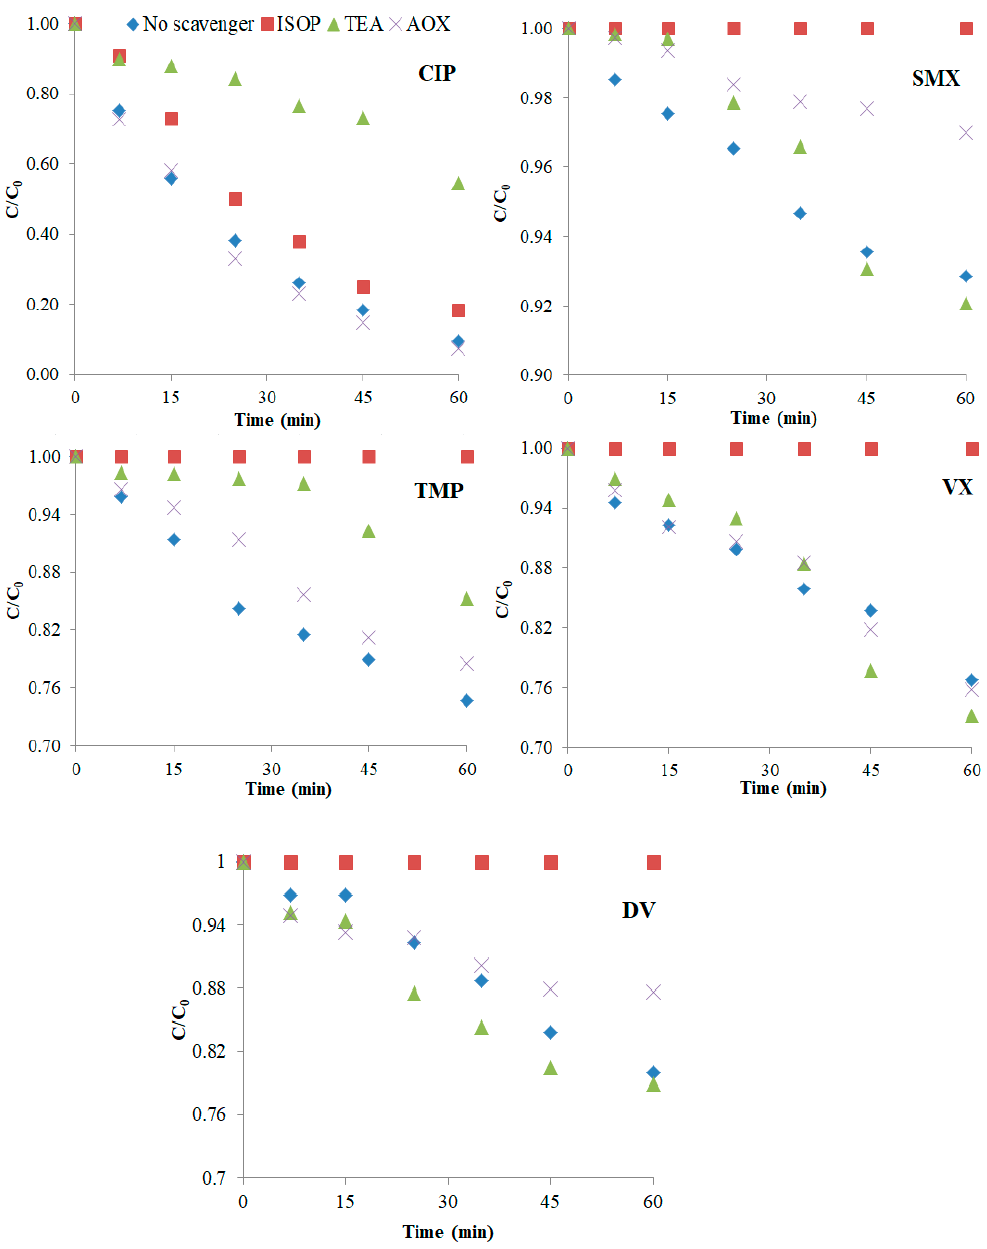
Figure 6. Degradation in the presence of scavengers (UV-A photocatalysis in MQ water). The hydroxyl radical was the most substantial contributor to the degradation of the pollutants, since the addition of ISOP completely hampered the degradation of four PhACs and reduced the CIP degradation rate by 50%. However, CIP was even further inhibited by TEA, indicating a high reactivity of this pollutant with super oxide radicals as well. The contribution of holes to the degradation was smaller, being relevant only for SMX, DV, and TMP, but always below 40%. Attention should be paid to the fact that a severe inhibition of the degradation does not mean that the compound is directly highly reactive towards the respective scavenger. This becomes evident by evaluating VX, TMP, and DV degradation, which was completely halted by the presence of isopropanol; however, in the latter’s absence, the reaction rates were also very low (Figure 1). The pH range in which the reactions took place (pH 0 = 6.7, pH final = 5.7) can be a decisive parameter given that the amount of available radicals and holes depends on it